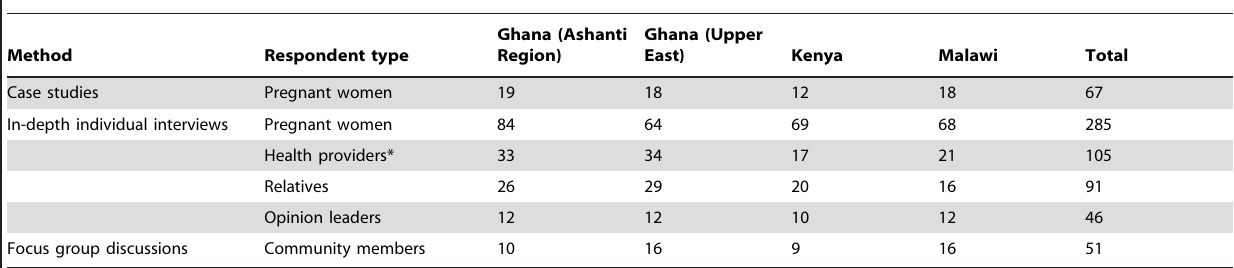
Table 4. Number and type of respondent by study